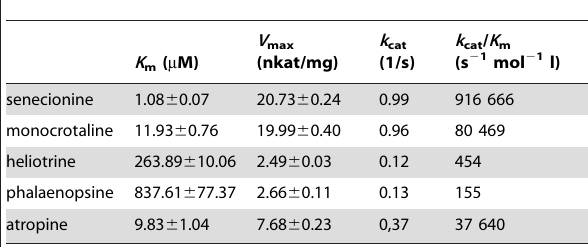
Table 3. Enzyme kinetics of recombinant Zv